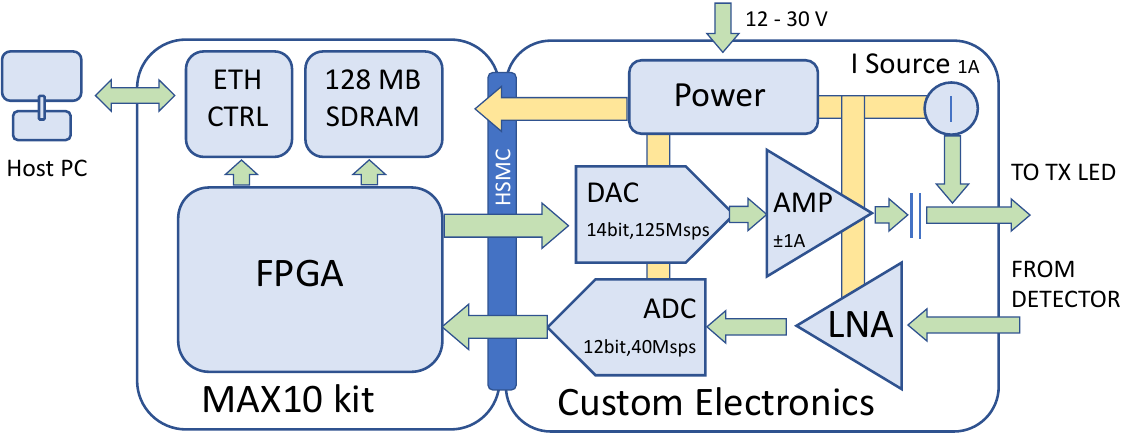
Figure 9. The VLC system based on the MAX10 developing kit and the custom board.